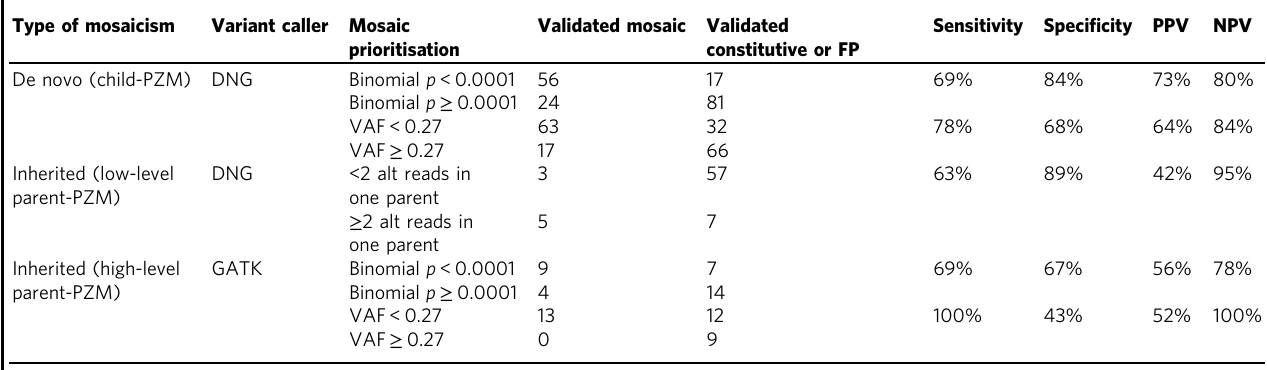
Table 1 Metrics for identifying different types of mosaic variants from whole exome sequencing data. Values are based on ultra- high-depth sequencing validation results, and any uninformative results were excluded Type of mosaicism